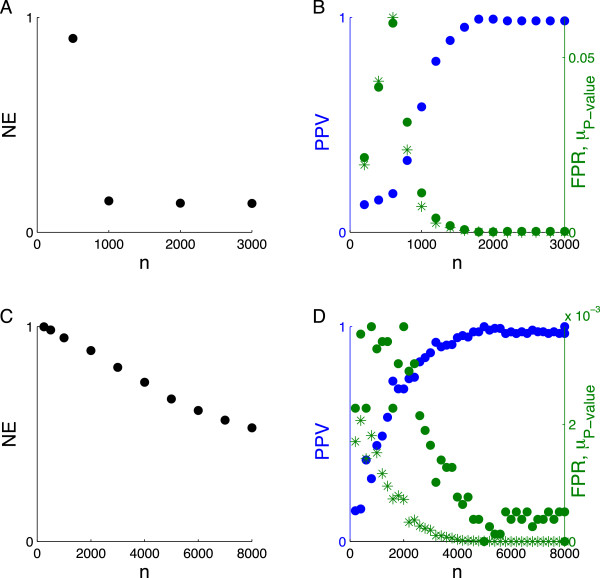
Measures of selection as a function of sample size for the measurement matrix of random genomic SNPs. Fixing s = 125 and p = 8,027, we measured the selection of true nonzero coefficients according to four metrics for h2 = 1 (A-B) and h2 = 0.5 (C-D). Shown in (A-C) is the normalized error of the coefficients (NE). Shown in (B-D) are the positive predictive value (PPV, blue dots), false positive rate (FPR, green dots), and median P -value (μP − value, green asterisks). The point n = 1, 000 corresponds to (ρ = 0.125, δ = 0.125) and n = 5, 000 to (ρ = 0.025, δ = 0.625) noted in Figure 1A and B respectively.